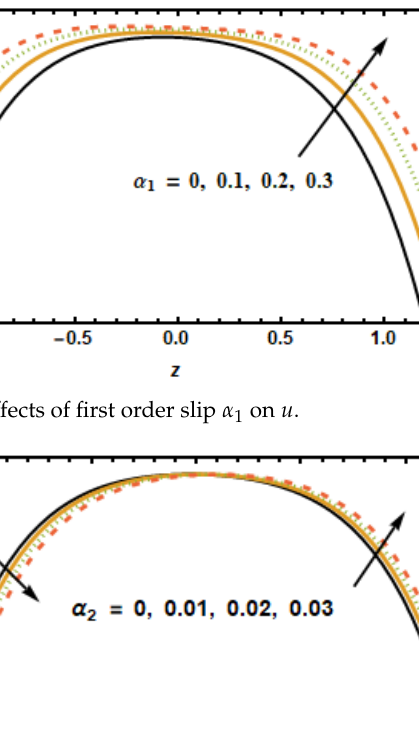
Figure 5. Effects of first order slip Figure 4. Effects of permeability on